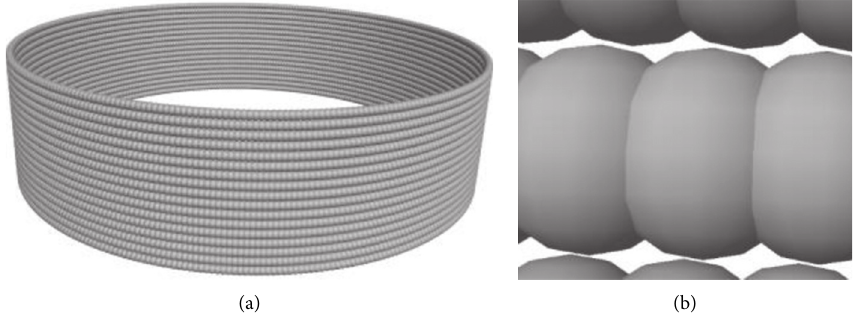
Figure 3: Clump rings: (a) layout of clump rings; (b) contacts within rings.